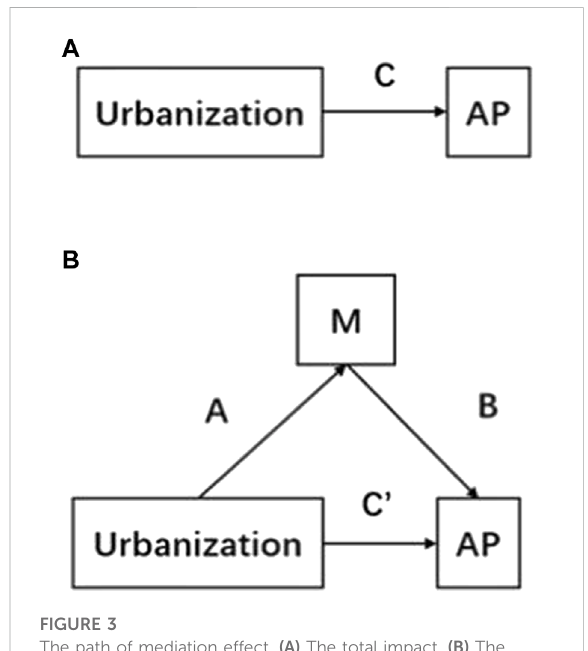
FIGURE 3 The path of mediation effect. (A) The total impact. (B) The direct and indirect